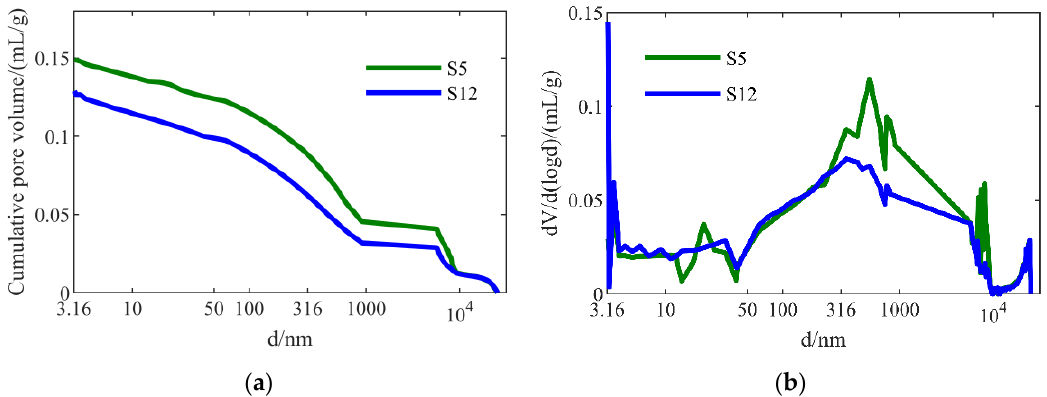
Figure 11. ( a ) Cumulative pore volume and ( b ) Pore-size distribution of blocks with different molding pressures (S5, 9 MPa; S12, 27 MPa) after 1-day curing.